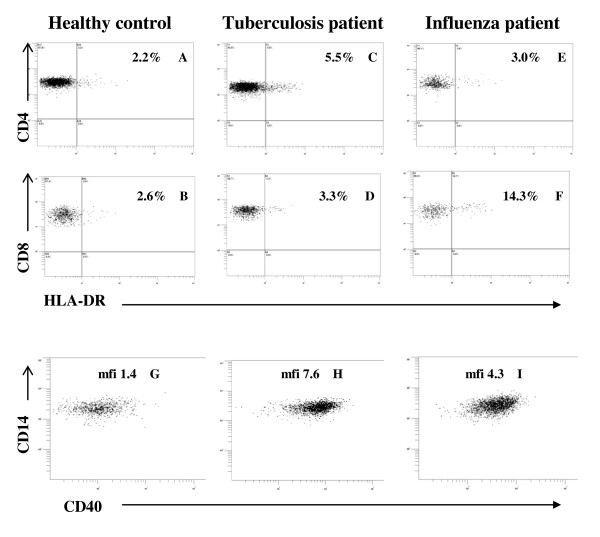
Flow cytometry method for quantitation of T cell and monocyte activation status. Representative dot plots from analysis of patient samples are shown. CD4+ T cells and CD8+ T cells gated on CD3+ CD4+ (A,C,E) and CD3+ CD8+ (B,D,F) lymphocytes from (A-B), a healthy control; (C-D), tuberculosis; (E-F), influenza; the inserted percentages indicate the fraction of HLA-DR+ cells. Monocyte plots gated on CD3- CD14+ monocytes from (G), a healthy control; (H), tuberculosis; (I), influenza; mfi = mean fluorescence intensity.